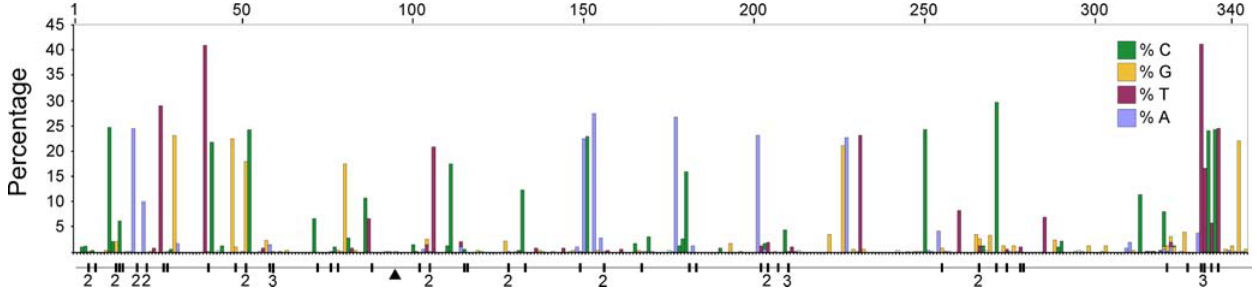
Figure 1. A plot of the frequency of the non-majority nucleotide bases across the 344 bp region of the HVR I for all adult penguins examined in this study. Only individuals that showed no heteroplasmies were used. The sites that showed transitional mutations are shown. When more than one transition was recorded at a site, the number is shown. The position of the single transversional mutation that was recorded is shown